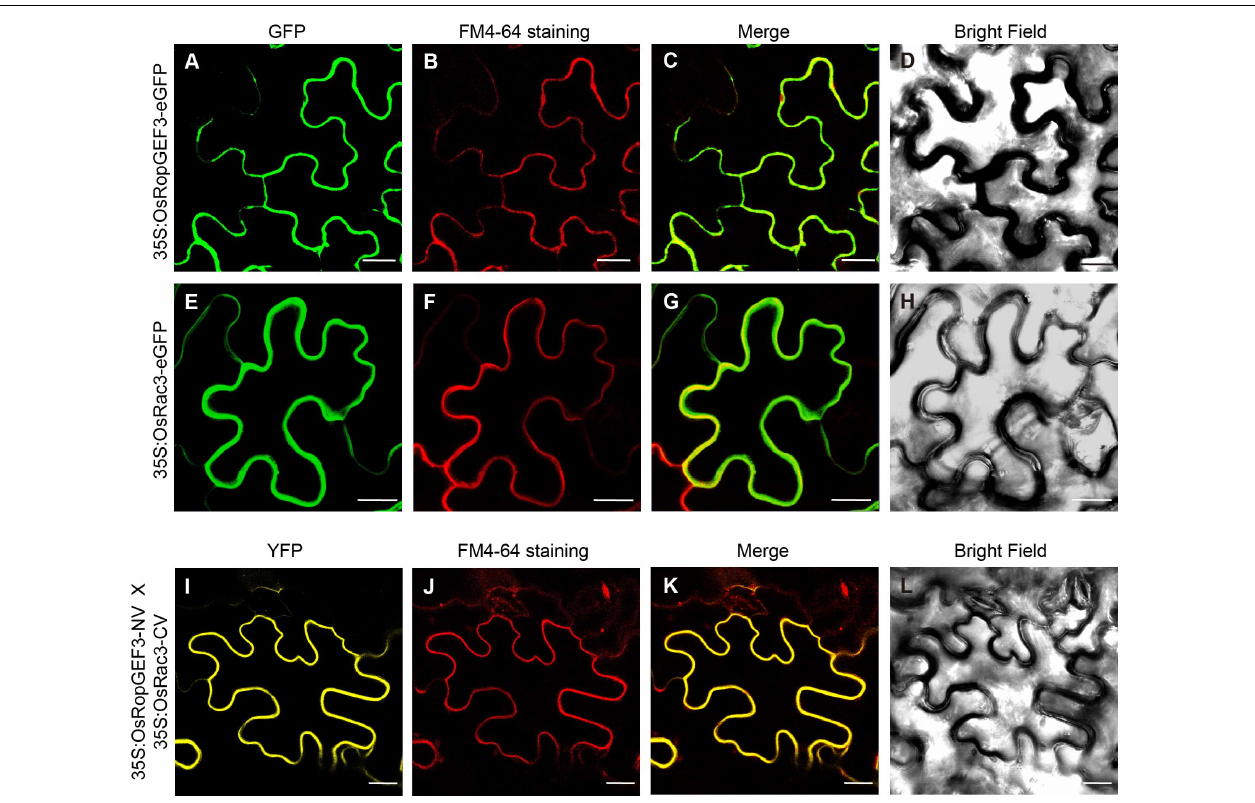
FIGURE 6 | Subcellular localization and BiFC of OsRopGEF3 and OsRac3 in tobacco leaf cells. (A–H) Subcellular localization of OsRopGEF3 and OsRac3. These proteins were tagged with enhanced green fluorescent protein (eGFP) and transiently expressed individually in tobacco ( Nicotiana benthamiana ) leaf cells using a 35S promoter. The cells were stained with FM4-64 dye to confirm PM localization. FM4-64 is detected as red fluorescence protein (RFP) signals. (I–L) BiFC visualization of OsRopGEF3 and OsRac3. OsRopGEF3 was tagged with the N-terminus of the Venus protein, and OsRac3 was tagged with the C-terminus. Both constructs were coexpressed inside the cells and were stained with FM4-64 dye to confirm their localization. BiFC signals were detected as YFP signals. Bars = 20 µ m.